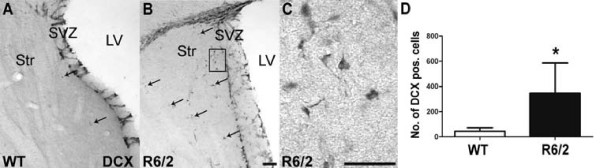
R6/2 mice show increased migration of neuroblasts to the affected striatum compared to controls, without signs of substantial striatal neurogenesis. Representative images of DCX-expressing neuroblasts in wild-type (WT; A) and R6/2 mice (R6/2; B), higher magnification (from insert in B) of cells exhibiting heterogeneous morphologies (C): Some cells possess only short or no processes, some display multiple well-developed processes characteristic of migrating cells. Arrows indicate migrating DCX positive cells leaving the SVZ. Quantification of DCX-positive cells in the striatum of WT and R6/2 mice, predominantly in close proximity to the SVZ (D). Error bars represent SD, * indicates p < 0.05. Scale bars represent 50 μm.